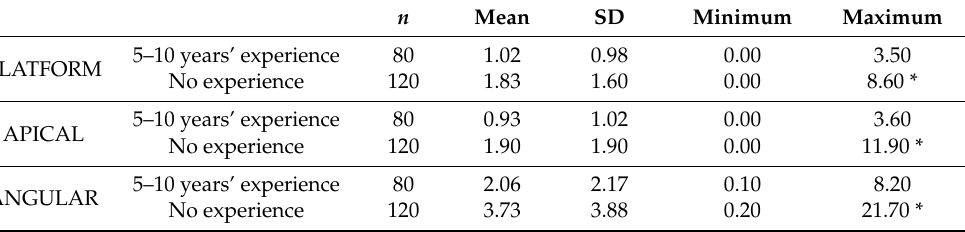
*: statistically significant di ff